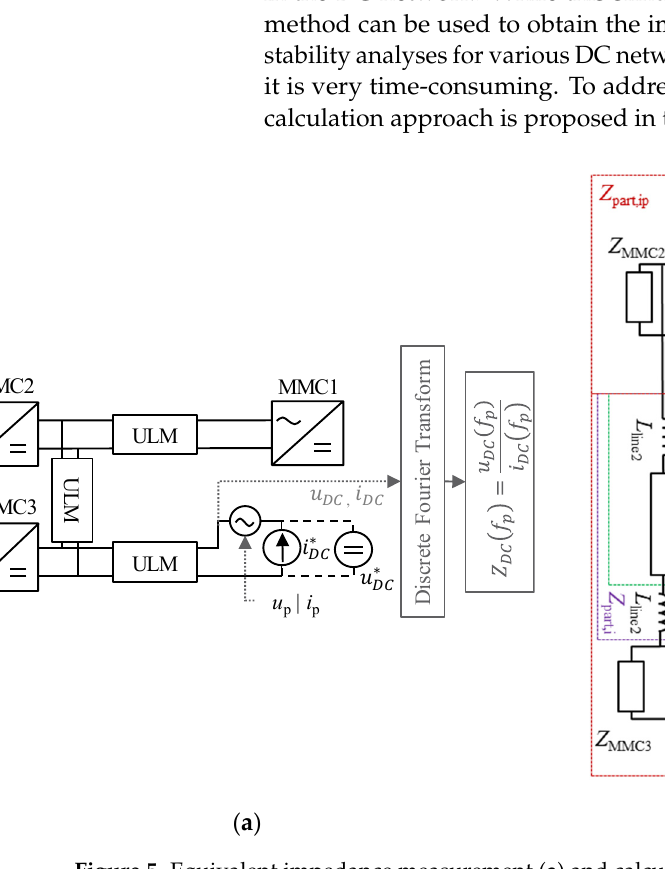
Figure 5. Equivalent impedance measurement ( a ) and calculation method ( b ), e.g., as seen from MMC 4.